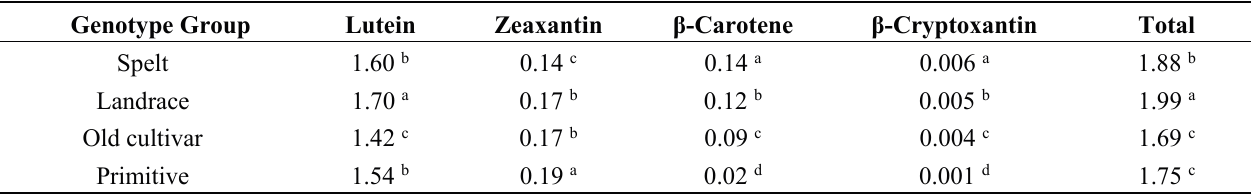
Table 2. Variation among genotype groups for different carotenoids content (mg/kg) in organically produced wheat grain.